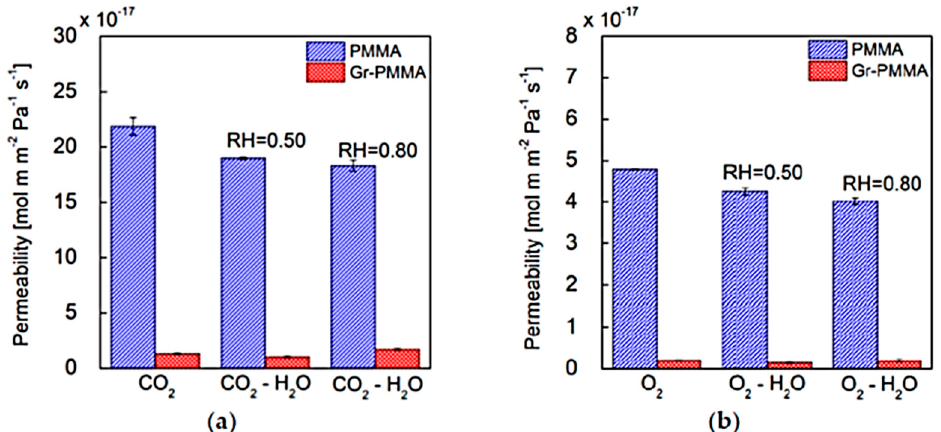
Figure 10. Relative ideal selectivity of CO 2 for poly(dimethyl siloxane)/graphene oxide nanocompo- site [116]. Reproduced with permission from Elsevier.